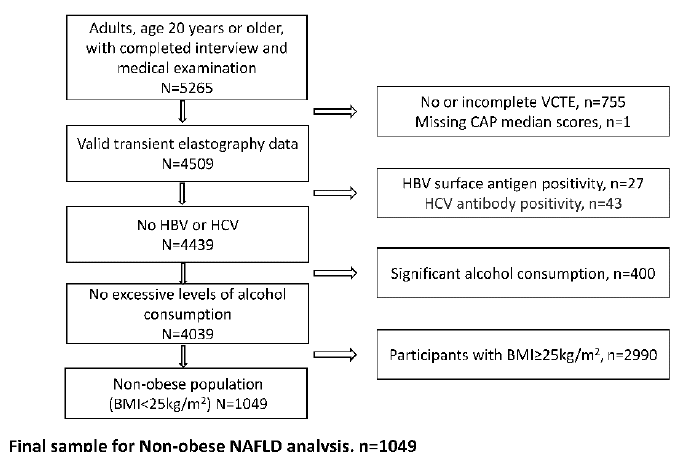
Figure 1. Study population flow